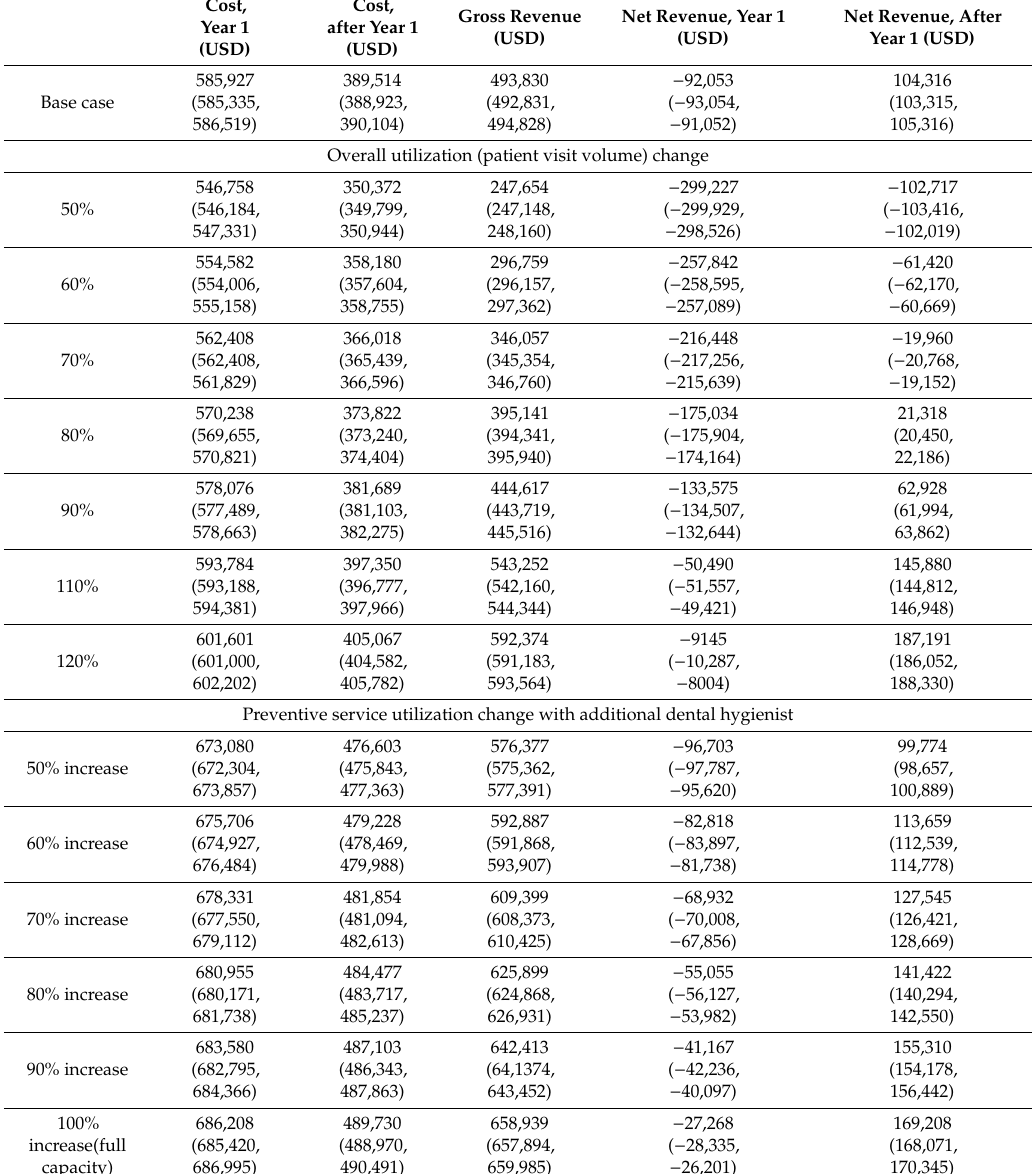
Table 2. Costs and revenues from medical–dental integration, per practice per